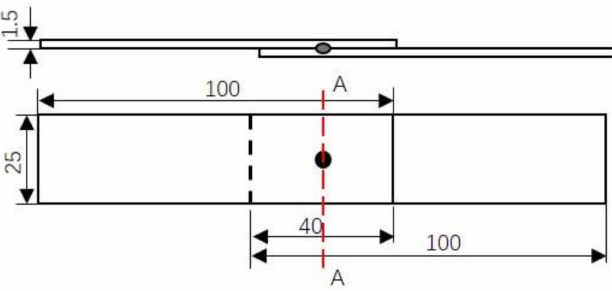
Figure 2. Specimen dimensions for tensile shear tests (unit: